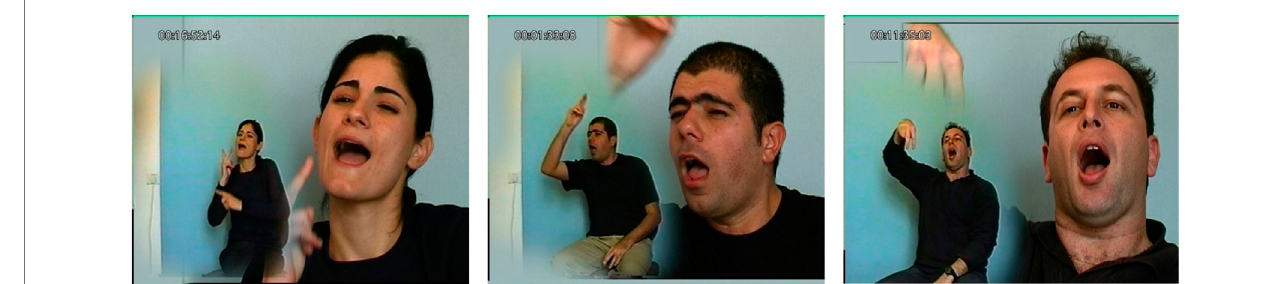
FIGURE 6 | Conventionalized, linguistic adverbial mouth shape, meaning “ protracted action. ”